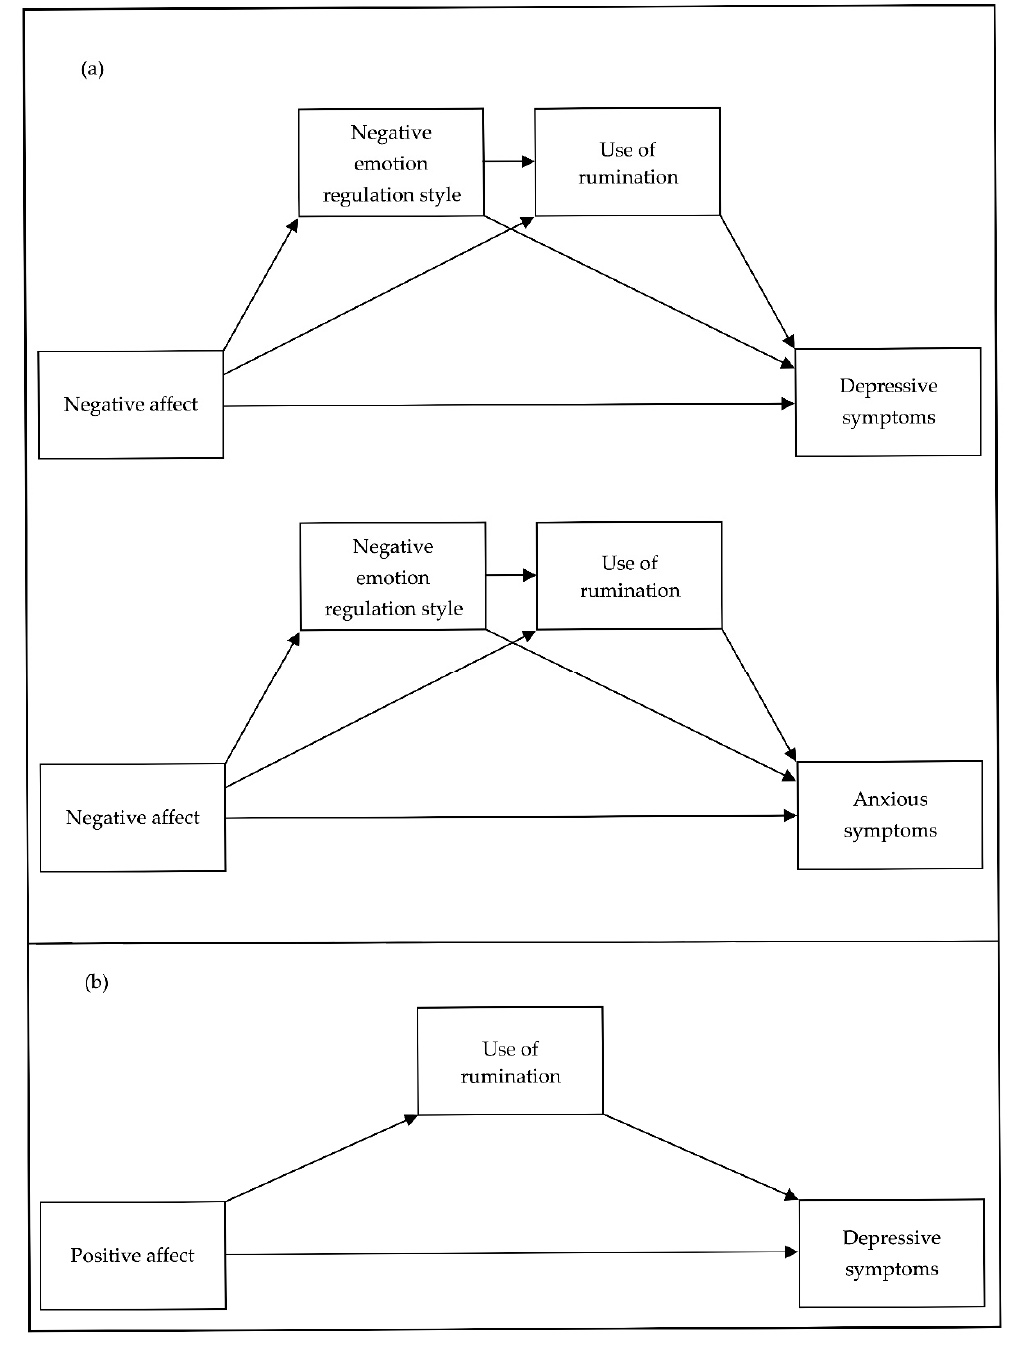
Figure 1. ( a ) The general outline for the multiple mediation models; ( b ) the general outline for the simple mediation model.